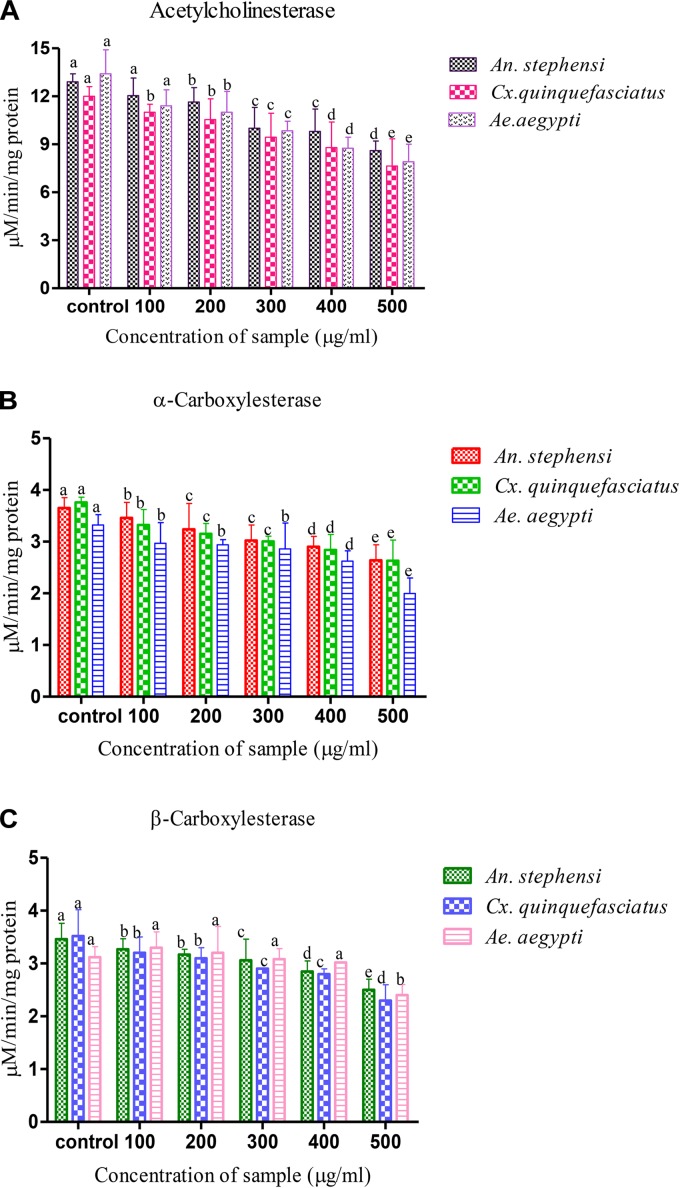
Biochemical analysis of (A) acetylcholine esterase, (B,C) α- and β- carboxylesterase Aspergillus terreus mycelium extract treated and untreated (Control) fourth instar larvae of vector mosquitoes Anopheles stephensi, Culex quinquefasciatus and Aedes aegypti. Statistical values followed by the same letter are not significantly differences according to Tukey test at P < 0.05 (one way ANOVA).